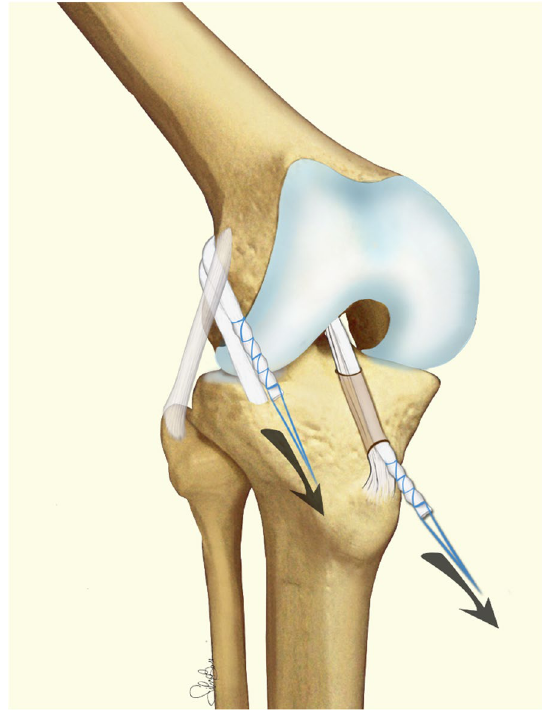
Fig. 1 Surgical technique reconstruction for ACL and lateral plasty described by Zarins and Carter